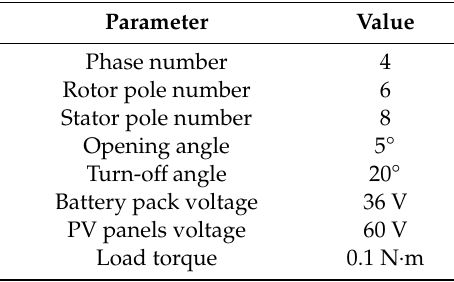
Table 2. The system parameters of the